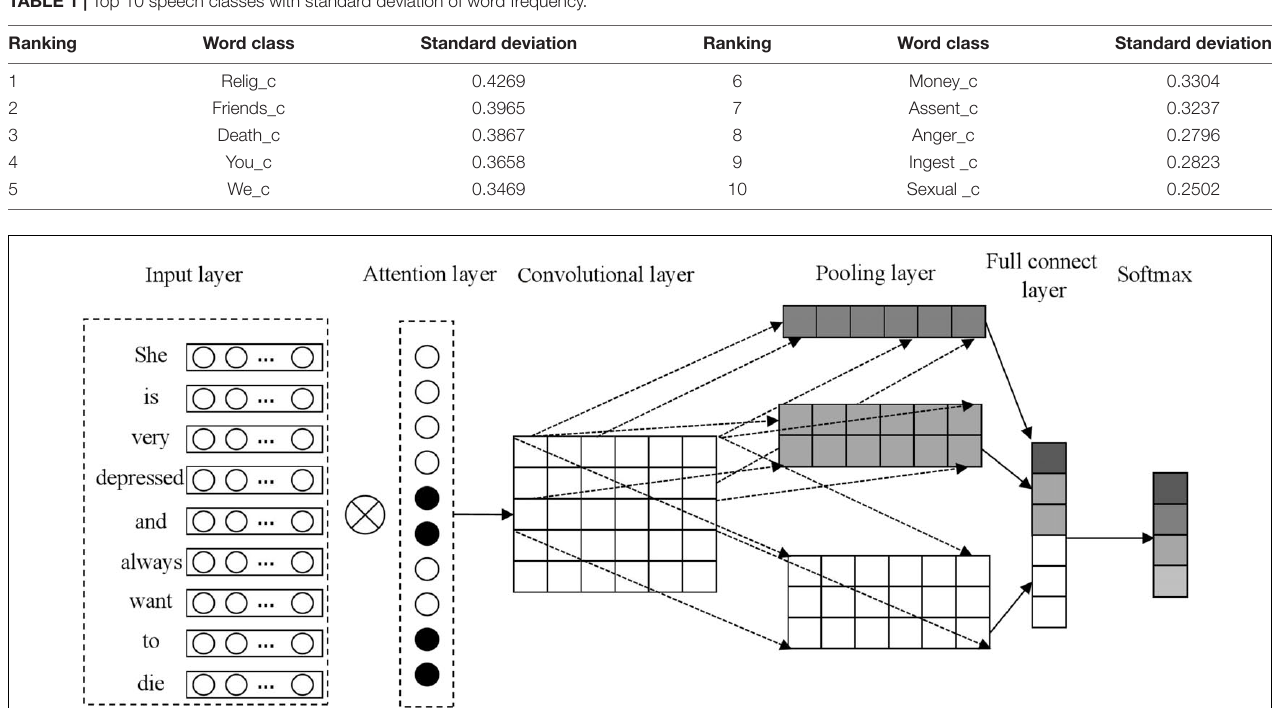
TABLE 1 | Top 10 speech classes with standard deviation of word frequency.